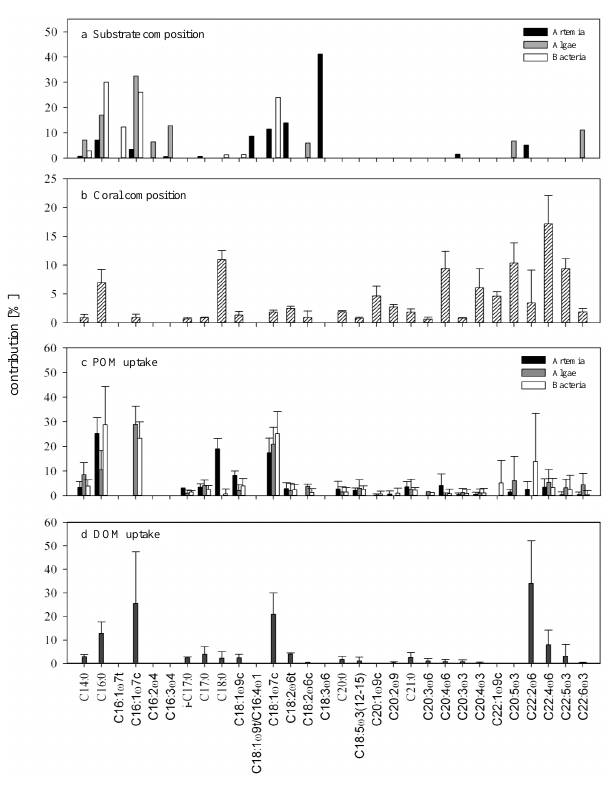
Fig. 2. PLFA profiles of (a) the particulate organic food sources Artemia , algae and bacteria (% contribution to total concentration), (b) L. pertusa, (c) POM-derived C incorporation into coral PLFAs by L. pertusa and (d) DOM transformation into coral PLFAs by L. pertusa (% contribution to total uptake). The bars in each figure represent average ±